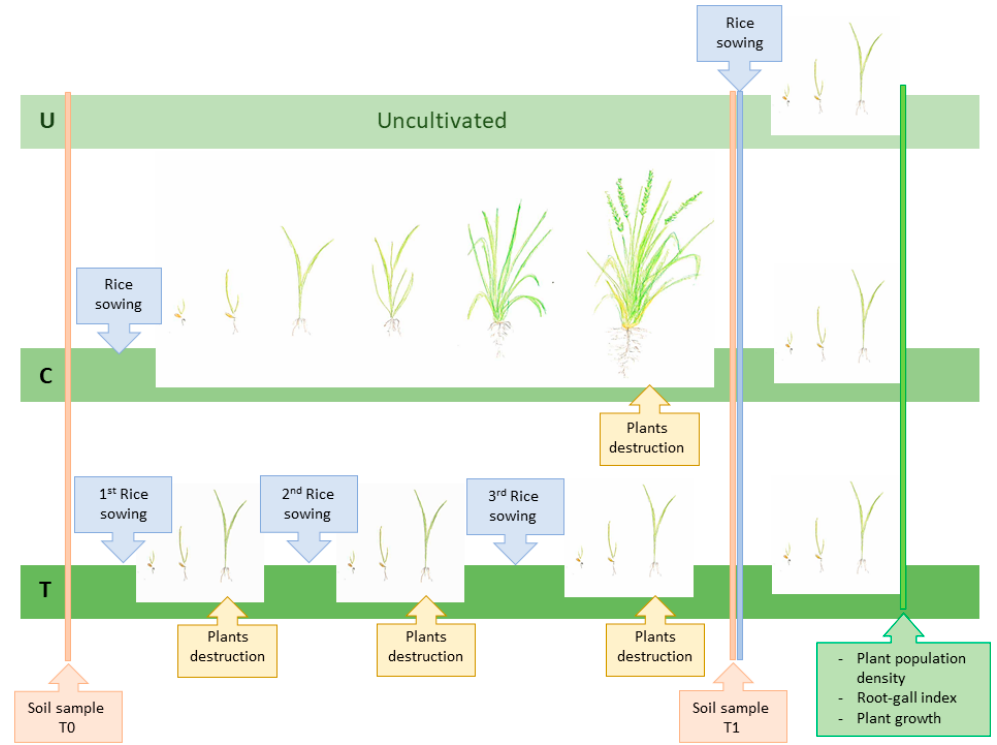
Figure 1. Illustration of the experimental design used to evaluate the trap crop technique in the management of Meloidogyne graminicola . Uncultivated (U), Control (C), and Treated (T). (Drawings by Giuseppe Mazza).